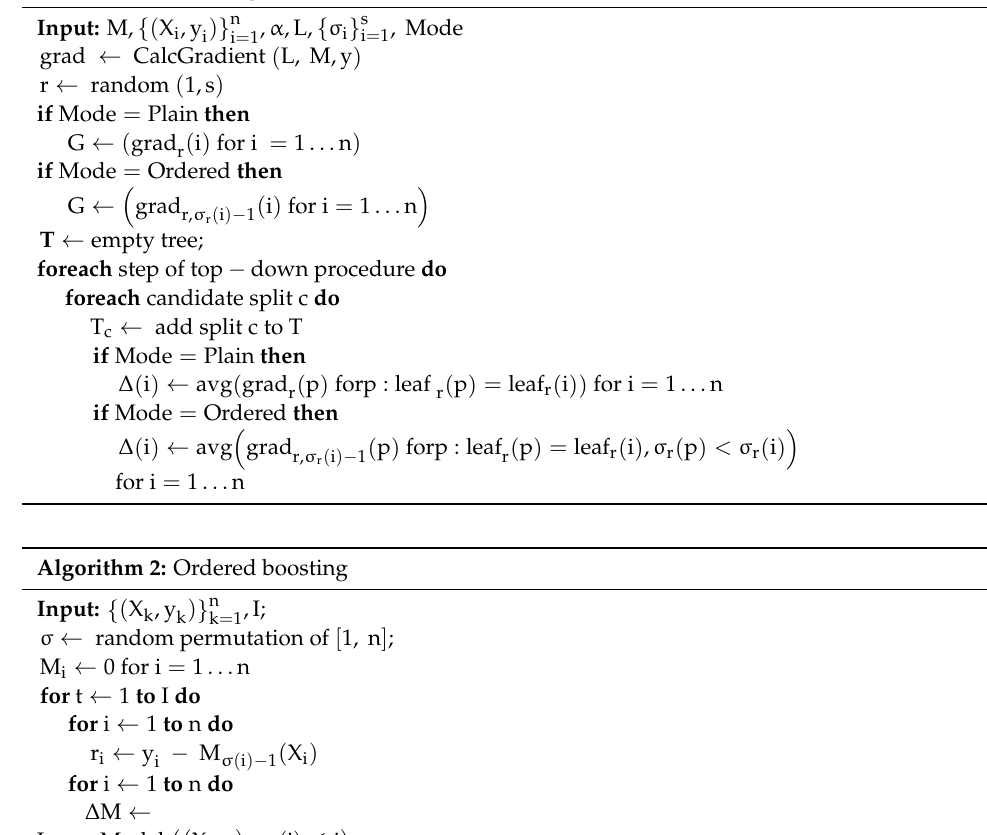
Algorithm 1: Building a tree in CatBoost